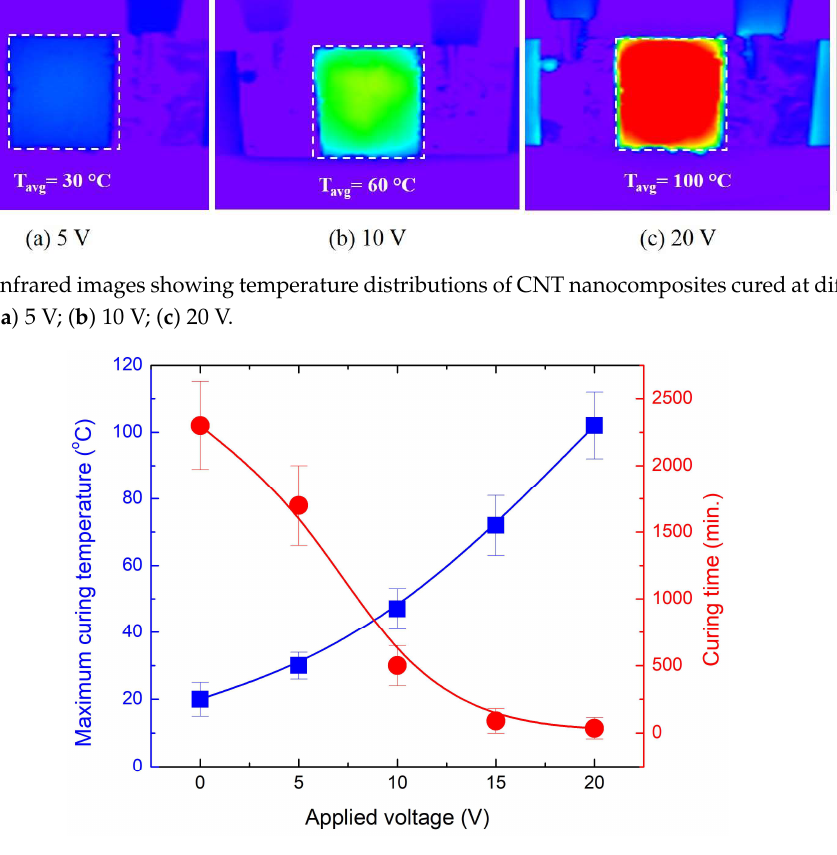
Figure 7. Maximum curing temperature and curing time for CNT nanocomposite cured at different applied voltages.